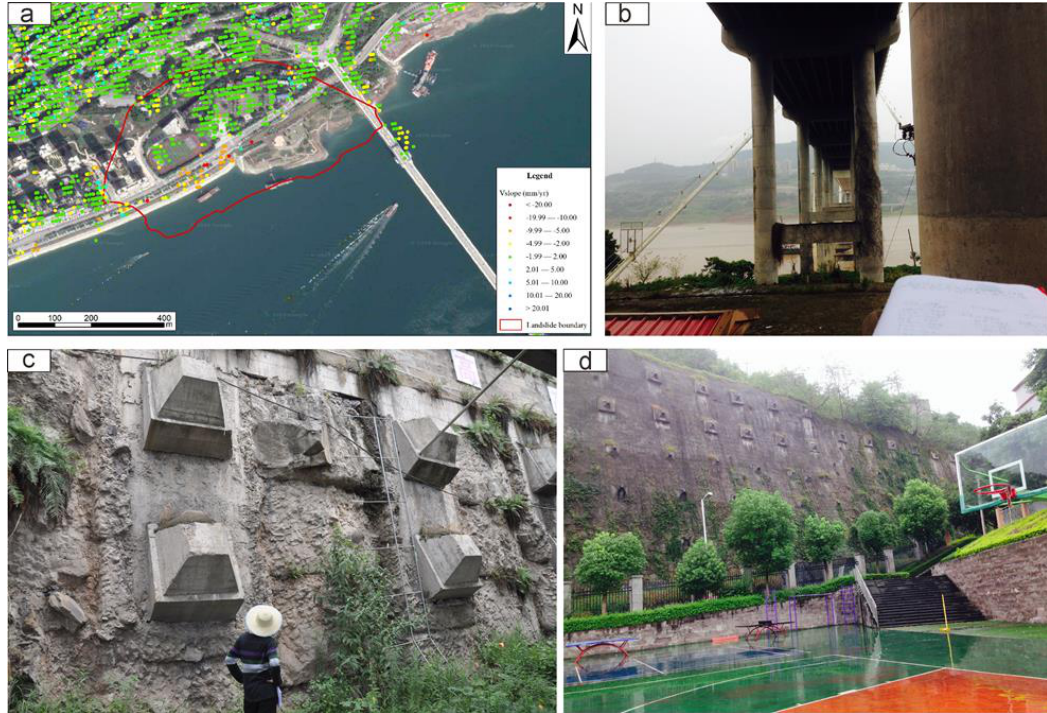
Figure 12. ( a ) PSInSAR deformation rate map of the Kangjiapo landslide. ( b ) Pier sinking observed at the middle part of the landslide body. ( c ) Anchors at the trailing edge of the Kangjiapo landslide. ( d ) Anchors at the landslide middle part of the landslide.